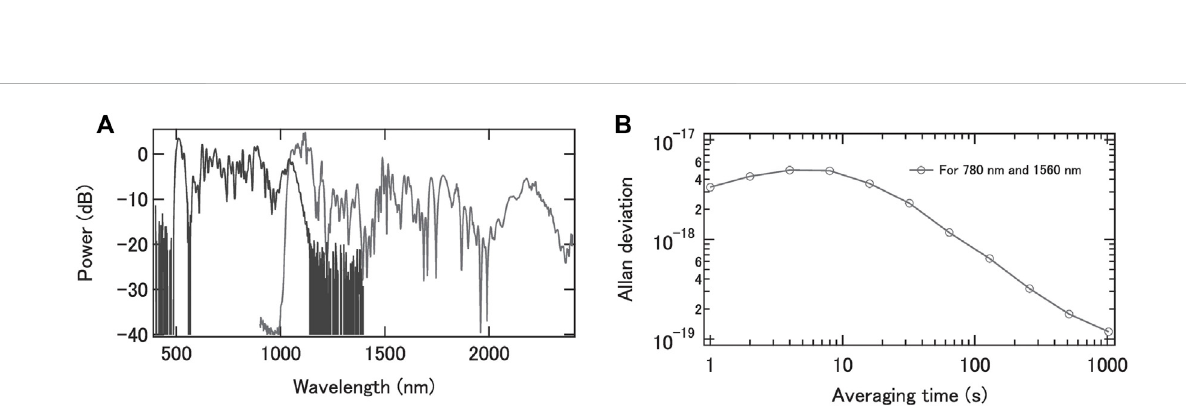
doped fi ber frequency comb and ampli fi ed in an Er-doped fi ber ampli fi er can also be frequency doubled and a highly coherent visible supercontinuum centered near 780 nm can be generated via coupling of the ultra-short frequency-doubled pulses into a photonic crystal fi ber. Via coherent stitching of an IR supercontinuum generated with another Er-doped fi ber